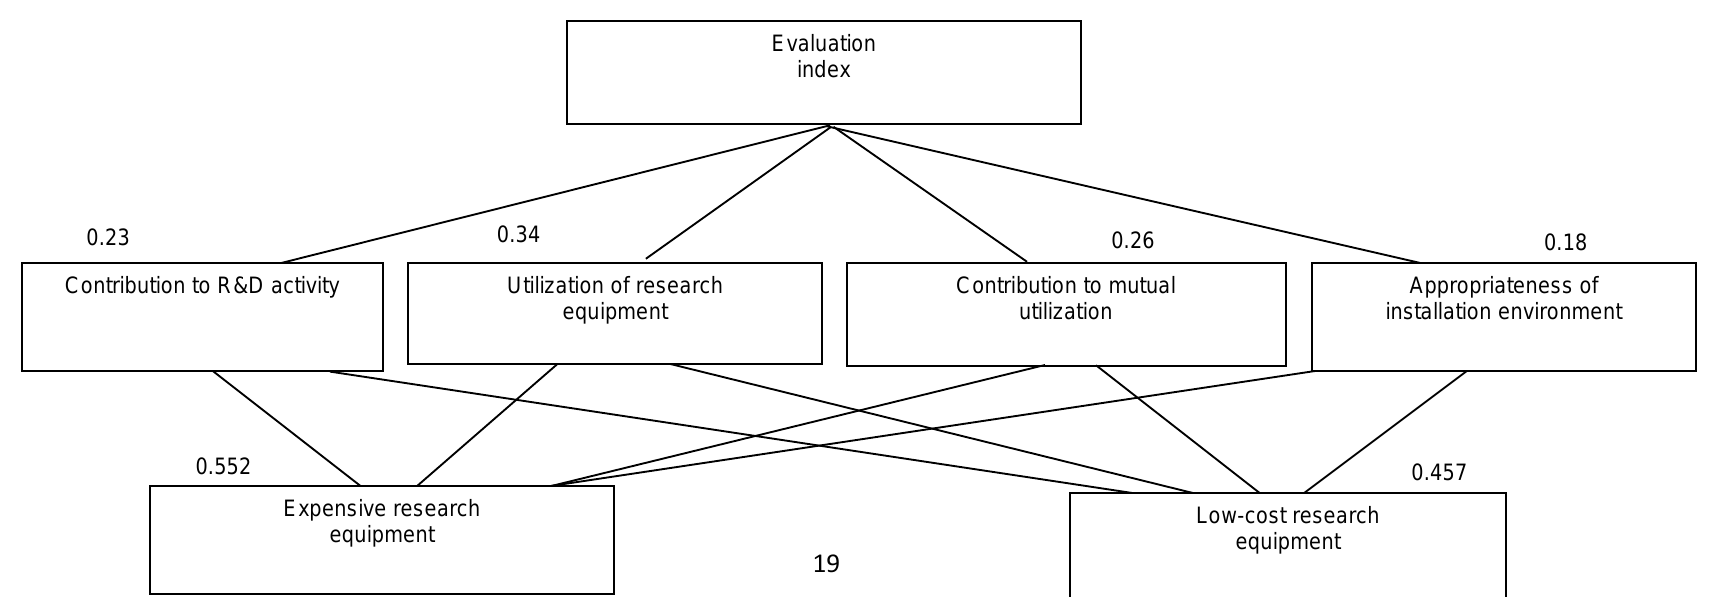
Figure 3. AHP application model for evaluation index improvement for research equipment